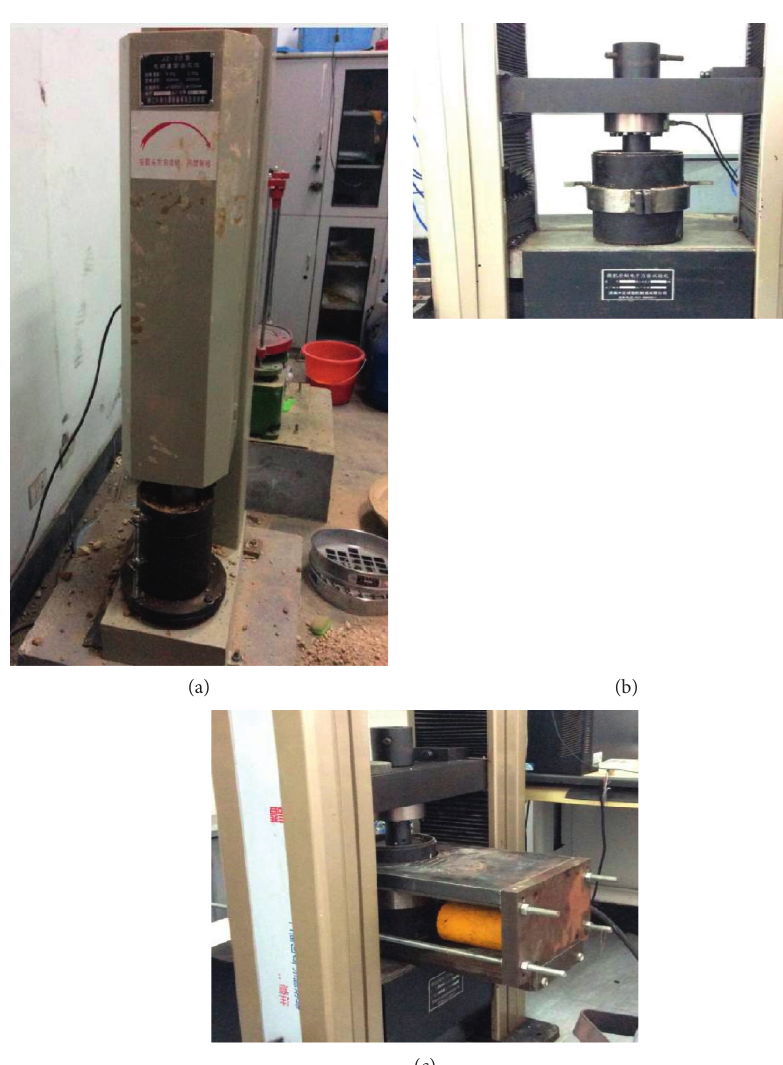
Figure 2: The geotechnical test equipment. (a) Compaction test; (b) cyclic compression test; (c) large direct shear